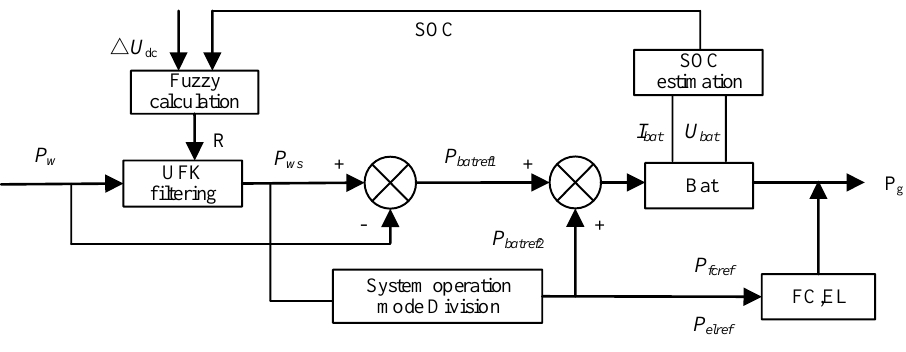
Figure 4. AUKF filter control diagram.